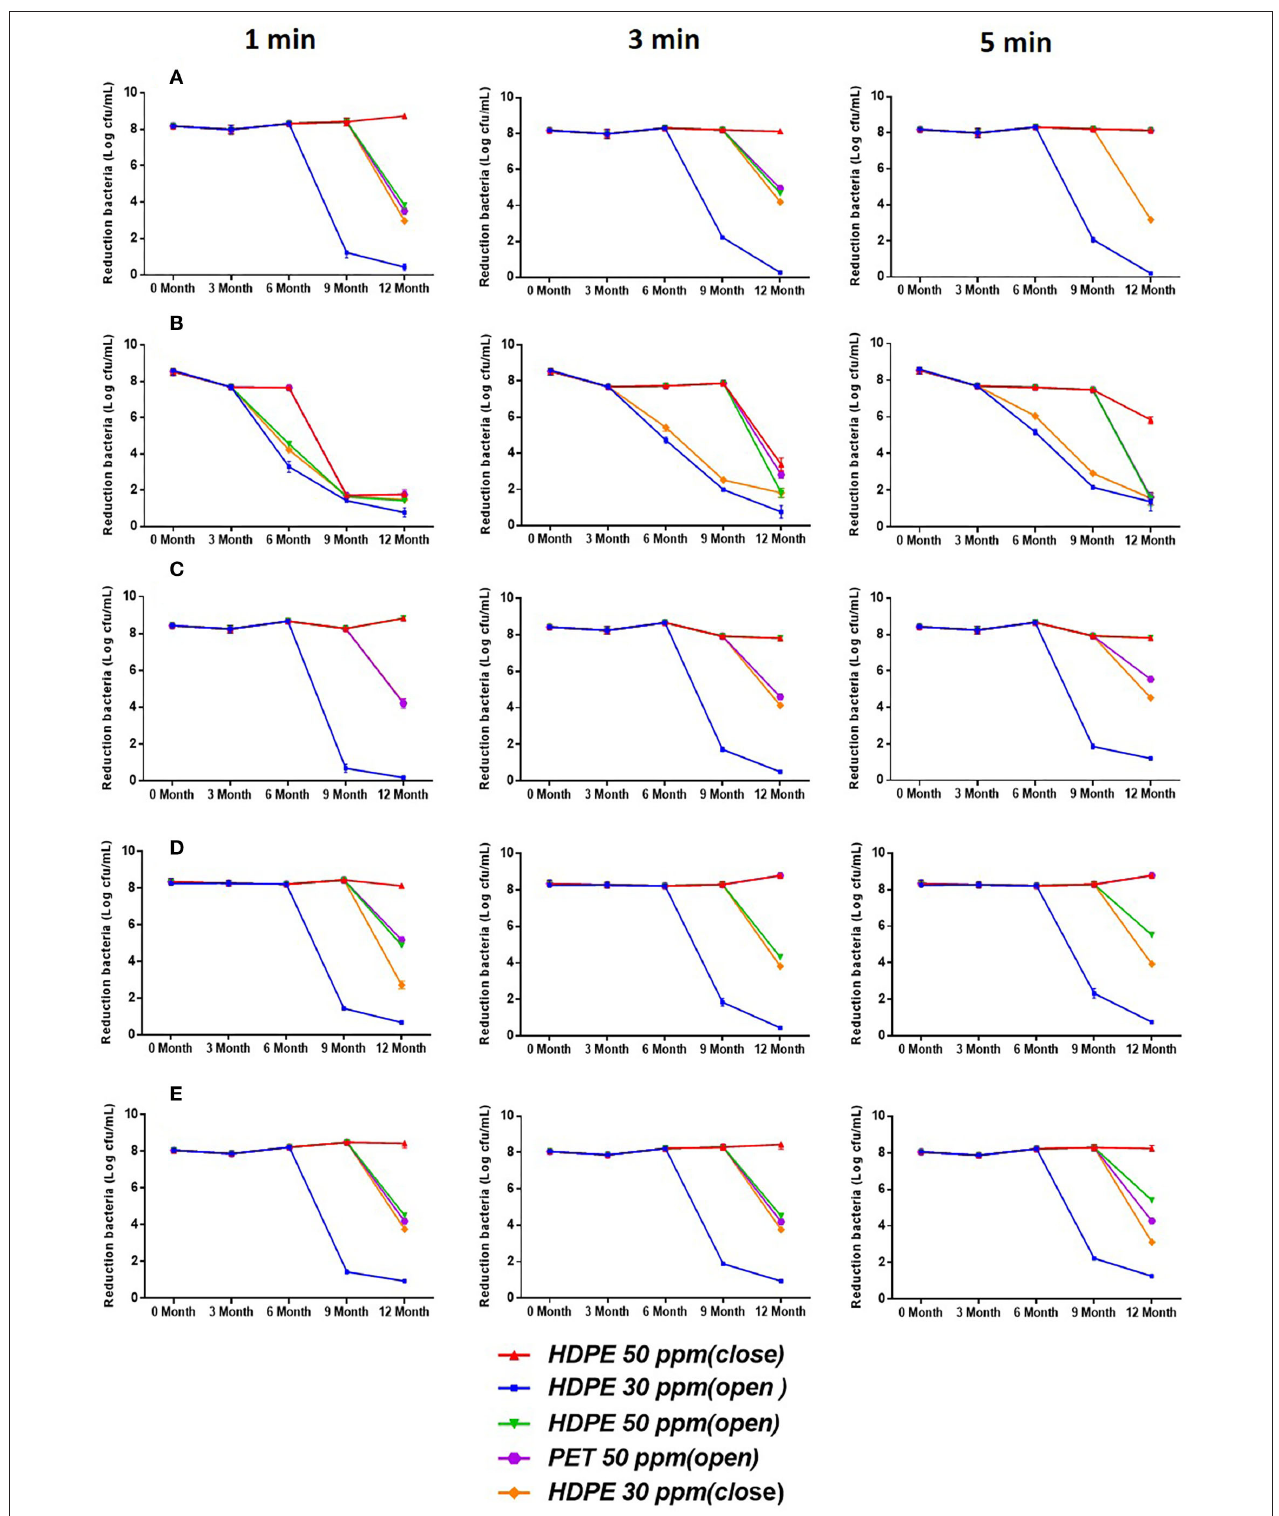
FIGURE 3 | Bactericidal activity of SAEW for 1-, 3-, and 5-min treatment against E. coli O157:H7, B. cereus, L. monocytogenes Scott A, S. aureus , and S. Enteritidis during 12-month storage. (A) ( E. coli O157:H7), (B) ( B. cereus ), (C) ( S. aureus ), (D) ( L. monocytogenes Scott A), and (E) ( S. enteritidis). Values are expressed as the means ± standard deviations ( n =